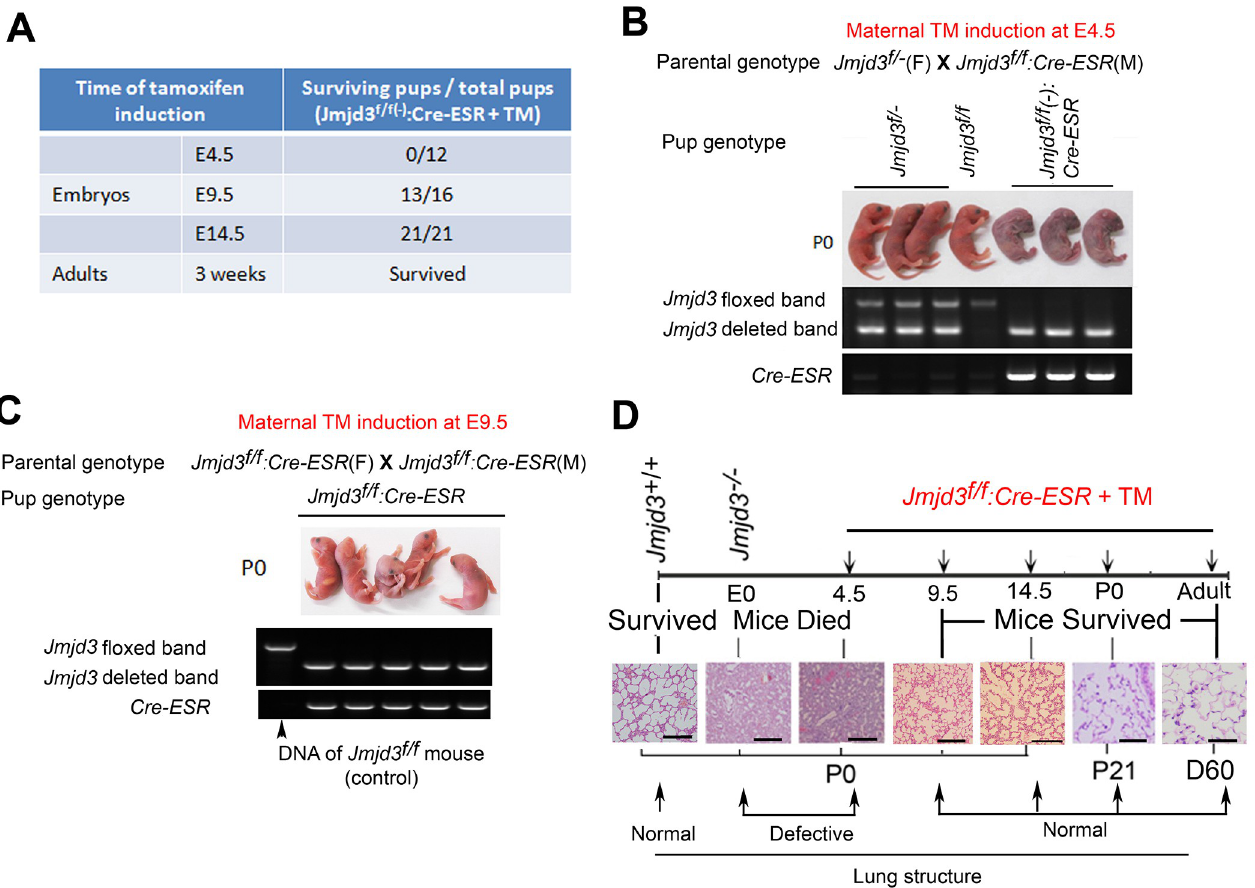
Fig 3. Stage-specific deletion reveals that Jmjd3 is dispensable for lung development in later E9.5 embryonic stage. (A) Jmjd3f/f mice were crossed with CAG-Cre/ESR mice in which Cre expression is globally induced with TM. The survival of Jmjd3f/f:Cre/ESR pups from maternal mice treated with TM at E4.5, E9.5, and E14.5 was determined. (B) PCR analysis of Jmjd3 deletion efficiency in Jmjd3f/f:Cre/ESR pups from maternal mice treated with TM at E4.5. (C) PCR analysis of Jmjd3 deletion efficiency in Jmjd3f/f:Cre/ESR pups from maternal mice treated with TM at E9.5. (D) H&E staining showing the stage-dependent effects of Jmjd3 deletion on lung architecture and its correlation with embryo viability. Bar = 500 µ m.